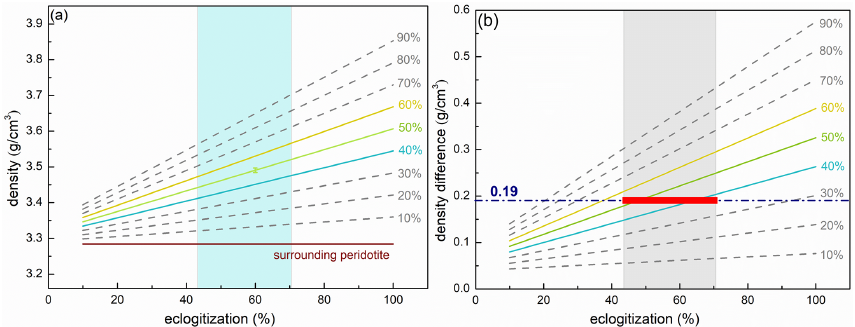
Figure 6. (a) The effect of eclogitization on the density of the subducted slab at ∼ 80km (2.6GPa and 625 ◦ C) along the Paleozoic geother- mal line. The percentage on the right represents the content of garnet, and the content of epidote is fixed at 5vol% by default. The content of garnets in Tibet is between 40vol% and 60vol%. The density represents the average density of the subducted slab with the entire eclogitic ocean lower crust and partially eclogitized lithospheric mantle; the degree of eclogitization refers to the lithospheric mantle. The rufous line represents the average density of surrounding peridotite in this study. The blue shading indicates the possible degree of eclogitiza- tion. (b) Density difference between eclogite with different degrees of eclogitization and surrounding peridotite. The red dashed solid line represents a density excess of 0.19gcm − 3 from the isostatic balance and the geoid anomaly (Matchette-Downes et al.,